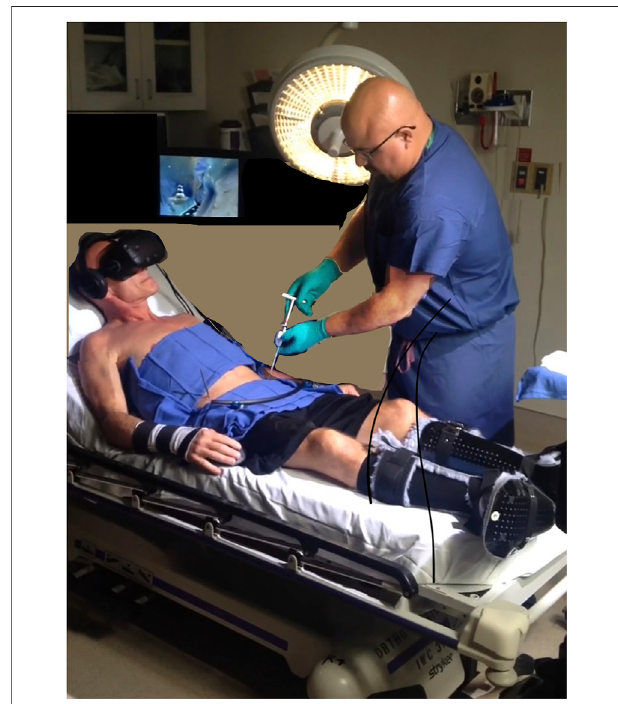
FIGURE 4 | VR analgesia may encourage patients to get minor surgical procedures performed in the outpatient clinic with analgesia instead of in the Operating Room with Anesthesia/sedation (much larger medication doses in the OR). Firoozabadi et al., 2020. Photo and copyright Hunter Hoffman,